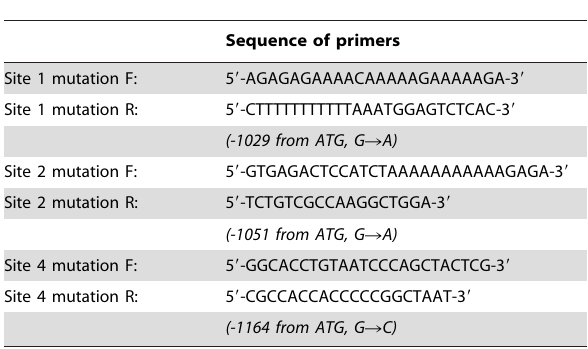
Table 4. Primers for site-directed mutation.